Question: State the chart type depicted above.
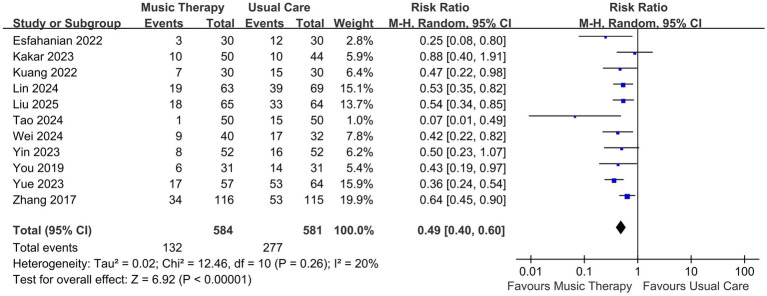
Answer: forest